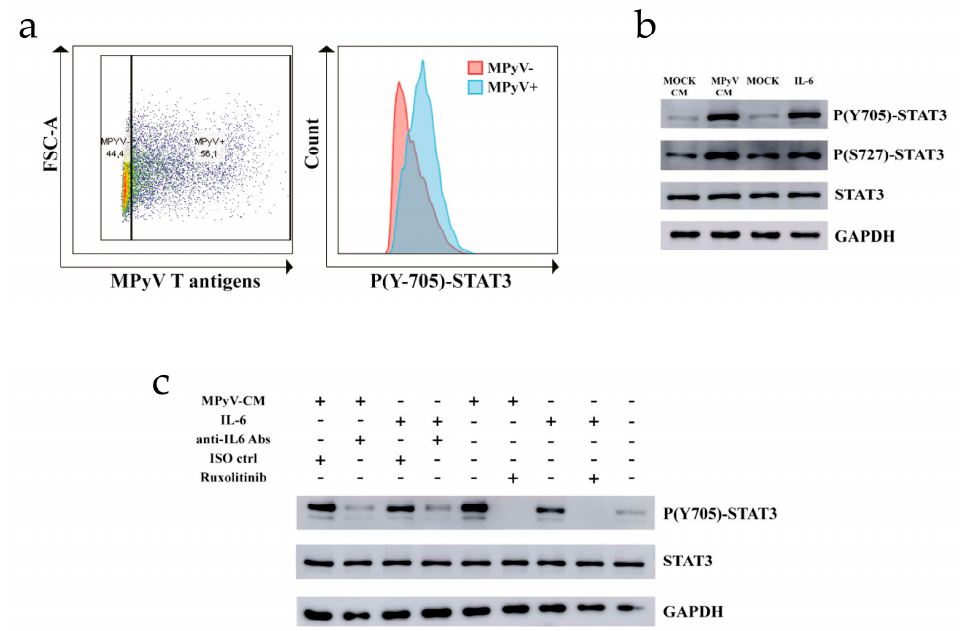
Figure 4. Induction of STAT3 phosphorylation in MEFs by MPyV-CM. ( a ) Fluorescence intensity of STAT3 phosphorylation at Y705 in T-antigen-positive or -negative MEFs. MEFs were infected with MPyV to reach approximately 50% T-antigen-positive cells to assess the distribution of STAT3 phosphorylation in one sample using PhosphoFlow. Red-colored histogram represents T-antigen-negative MEFs, whereas blue-colored histogram represents T-antigen-positive MEFs. ( b ) Western blot analysis of STAT3 phosphorylation at Y705 and S727 in MEFs treated with MPyV-CM or MOCK-CM. Recombinant IL-6 (10 ng/mL) was used as the positive control. Total STAT3 and GAPDH served as the loading control. ( c ) The effect of anti-IL-6 antibodies (Abs) and JAK1/2 inhibitor Ruxolitinib on the MPyV-CM-induced STAT3 phosphorylation at Y705. As a control for anti-IL-6 antibodies, an isotype antibody control (ISO ctrl) was included. The results are representative of three independent experiments.